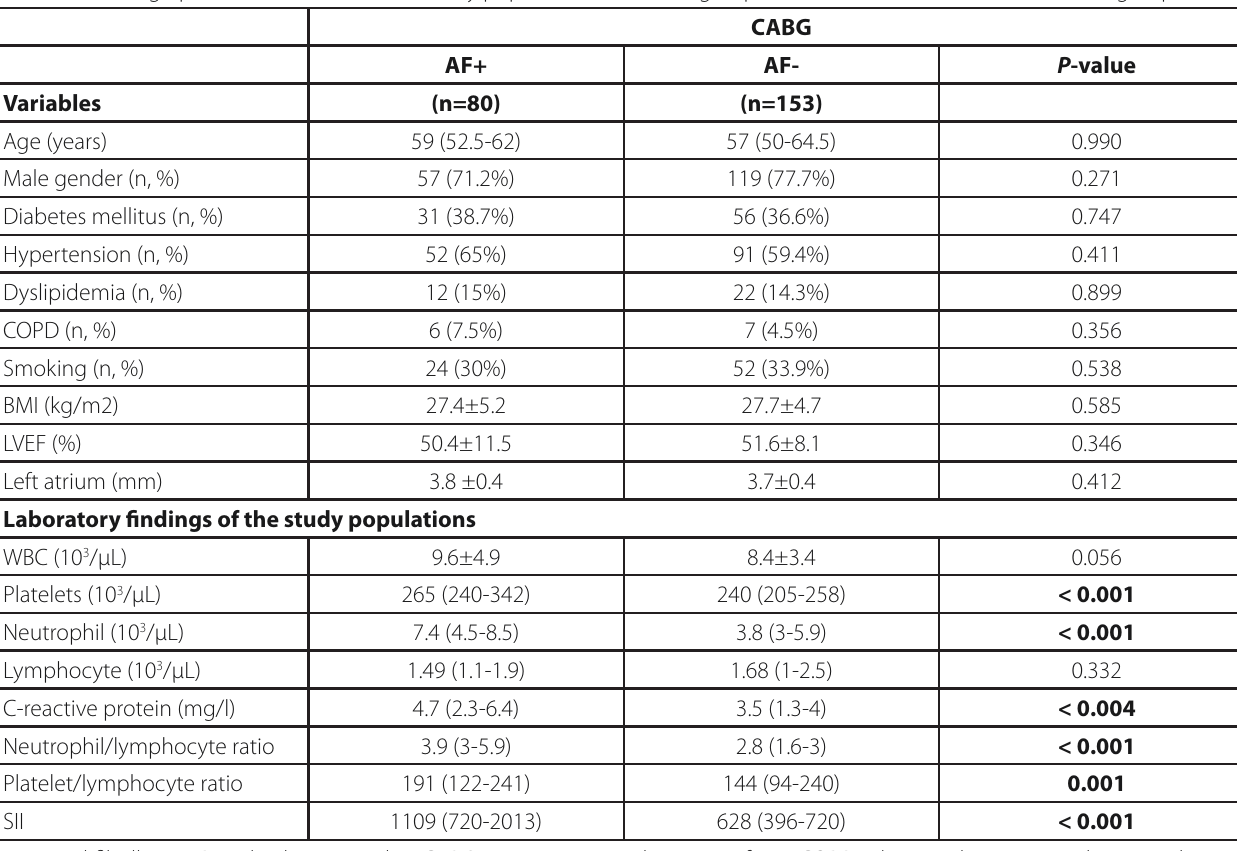
AF=atrial fibrillation; BMI=body mass index; CABG=coronary artery bypass grafting; COPD=chronic obstructive pulmonary disease; LVEF=left ventricular ejection fraction; SII=systemic immune-inflammation index; WBC=white blood cells